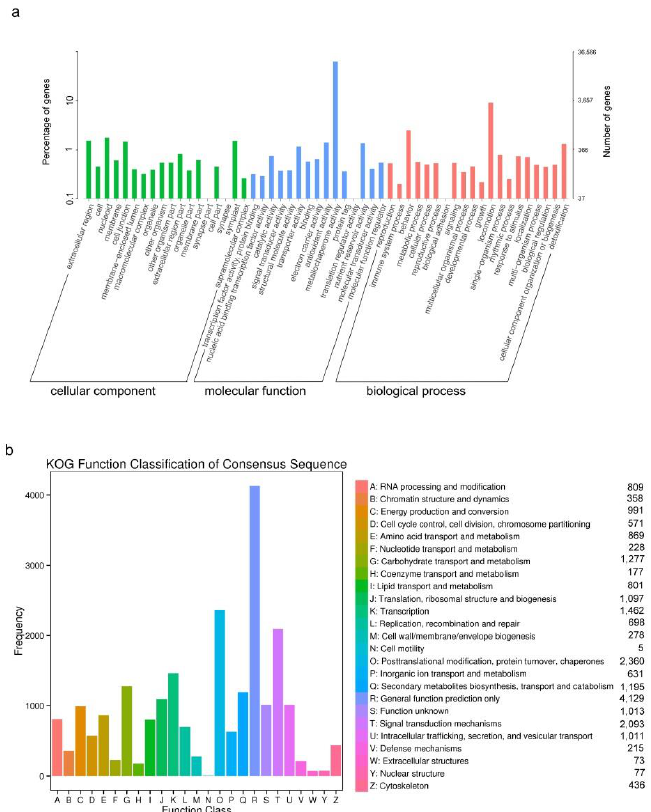
Figure 5. The annotation of PFM and YFM unigenes based on GO ( a ) and KOG databases ( b ). ( a ) GO annotation. The GO annotation was used to classify the possible functions of the unigenes based on NR annotation. The X -axis represents the category of the GO function. The Y -axis on the left indicates the percentage of the total number of unigenes. The Y -axis on the right shows the number of unigenes common to the corresponding GO function. In total, 36,566 unigenes were classified into 53 functional terms; the biological process, cellular component, and the molecular function categories include 19, 20, and 15 GO terms, respectively. ( b ) KOG annotation of unigenes. The X -axis is the categories of the KOG annotation, capital letters represent related categories and are listed on the right. The Y -axis on the left indicates the total number of unigenes and the specific unigene numbers are marked after related categories. For KOG annotation, these unigenes were annotated into 25 categories, and 1195 unigenes were annotated into the group of “secondary metabolites biosynthesis, transport, and